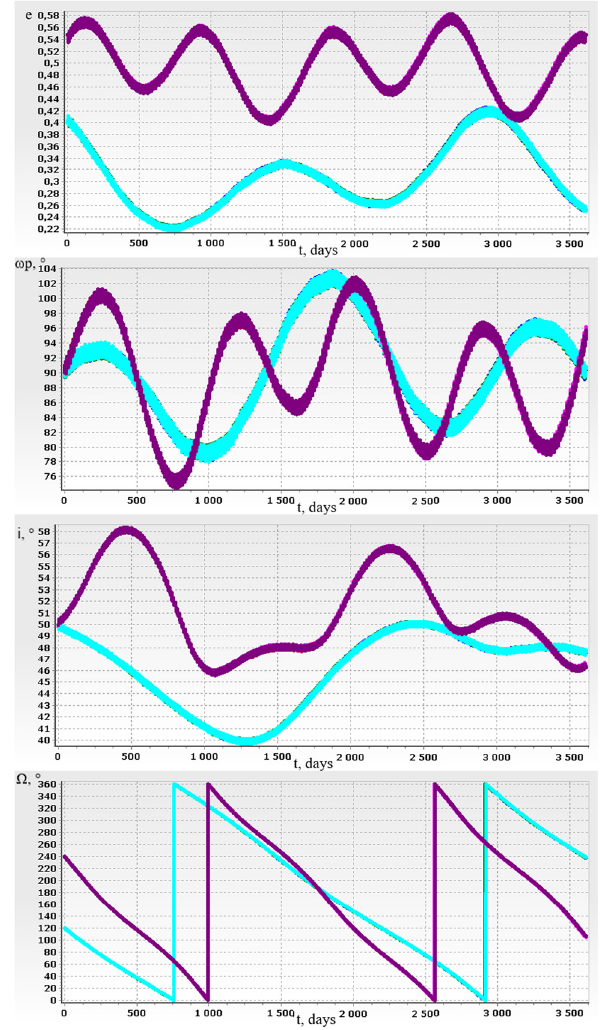
Figure 1: 2 × 3 constellation on frozen elliptic orbit evolution over 10